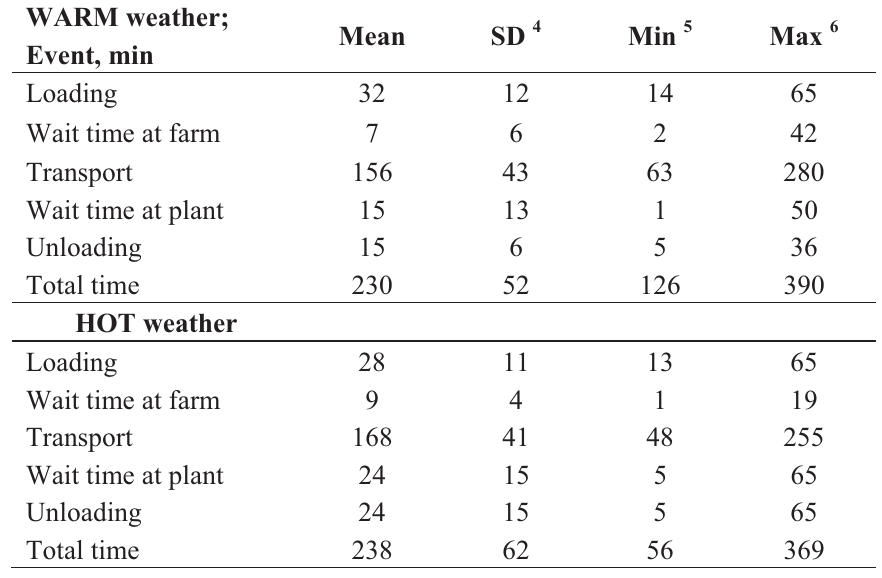
Table 3. Experiment 1. Descriptive statistics for transport events 1 for sprinkling method in market weight pigs for both WARM 2 and HOT 3